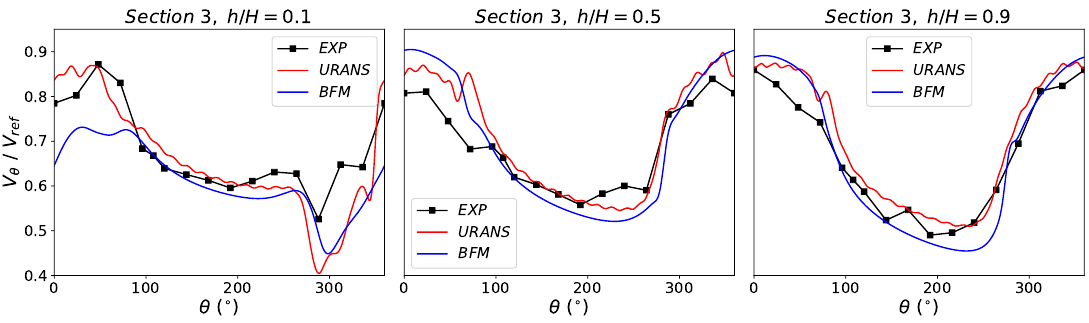
Figure 15. Azimuthal distribution of absolute tangential velocity in Section